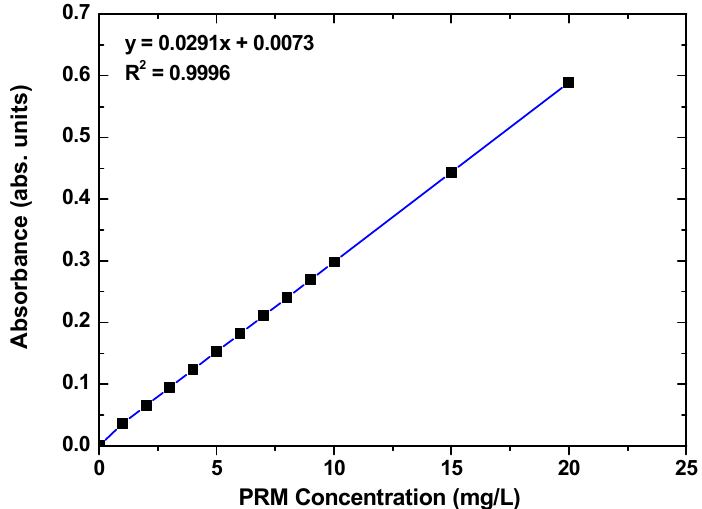
Figure 3. Calibration curve of pramipexole dihydrochloride (PRM). In addition, with the use of the mass balance equation, as presented below (Equation (1)), the quantity of pramipexole that is taken up at the equilibrium phase was cal- culated Q e (mg/g) (where C 0 and C e (mg/L) are the initial and equilibrium concentrations